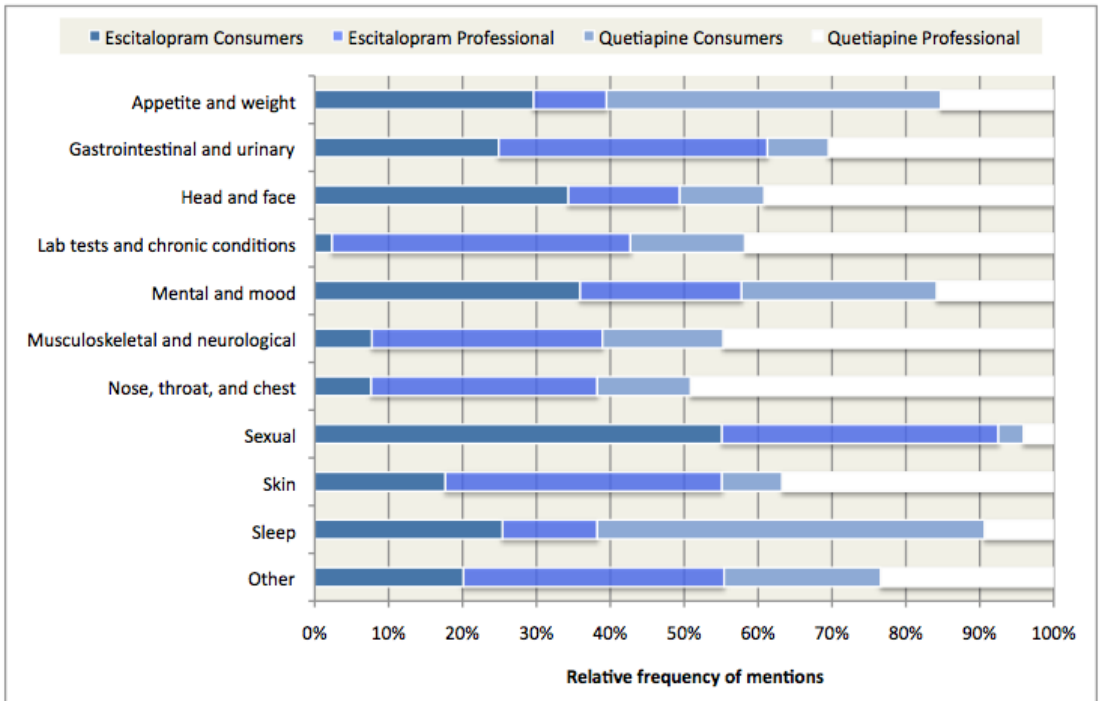
Figure 1. Relative frequency of mentions of effects in consumer reviews and in professional medication descriptions according to effect